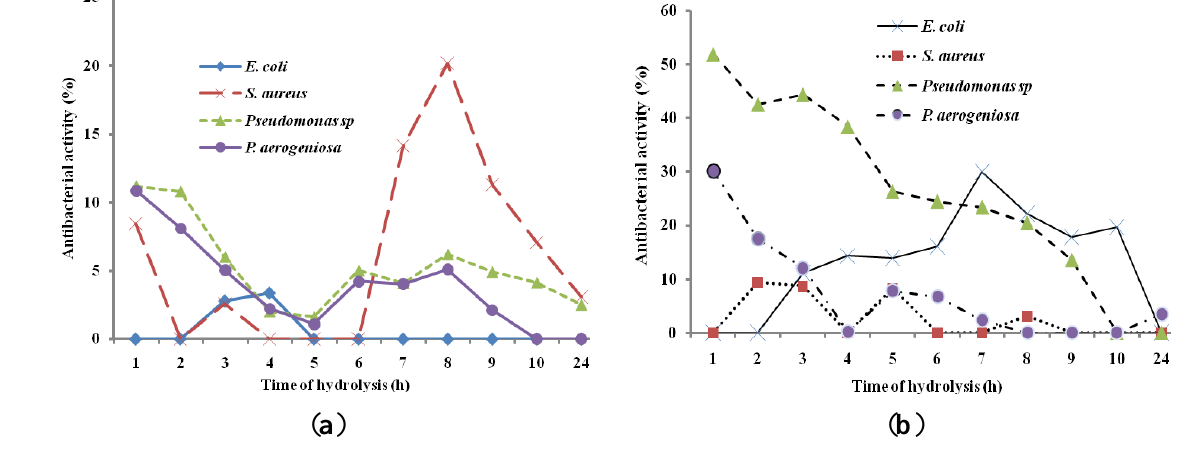
Figure 2. Bacterial growth inhibitions (%) of A. Lecanora hydrolysates produced by bromelain ( a ) and papain ( b ). Results are the average of triplicate determinations (mean ±